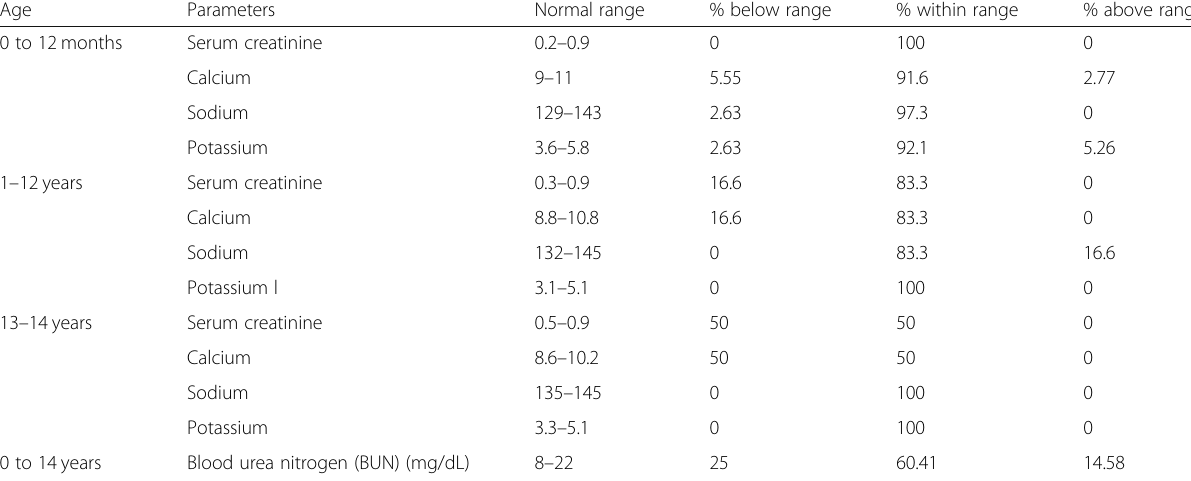
Table 2 Chemical pathological assays in study